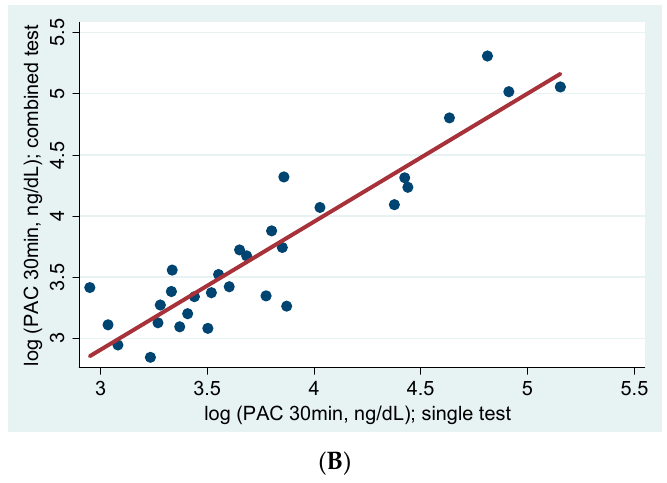
Figure 1. Linear regression analysis of PAC responsiveness to ACTH stimulation between single (AST alone) and combined (AST under 1-mg DS) tests. ( A ) All patients: 30 min, R 2 = 0.75, p -value < 0.01; 60 min, R 2 = 0.76, p -value < 0.01; ( B ) PA patients: 30 min, R 2 = 0.85, p -value < 0.01; 60 min, R 2 = 0.85,